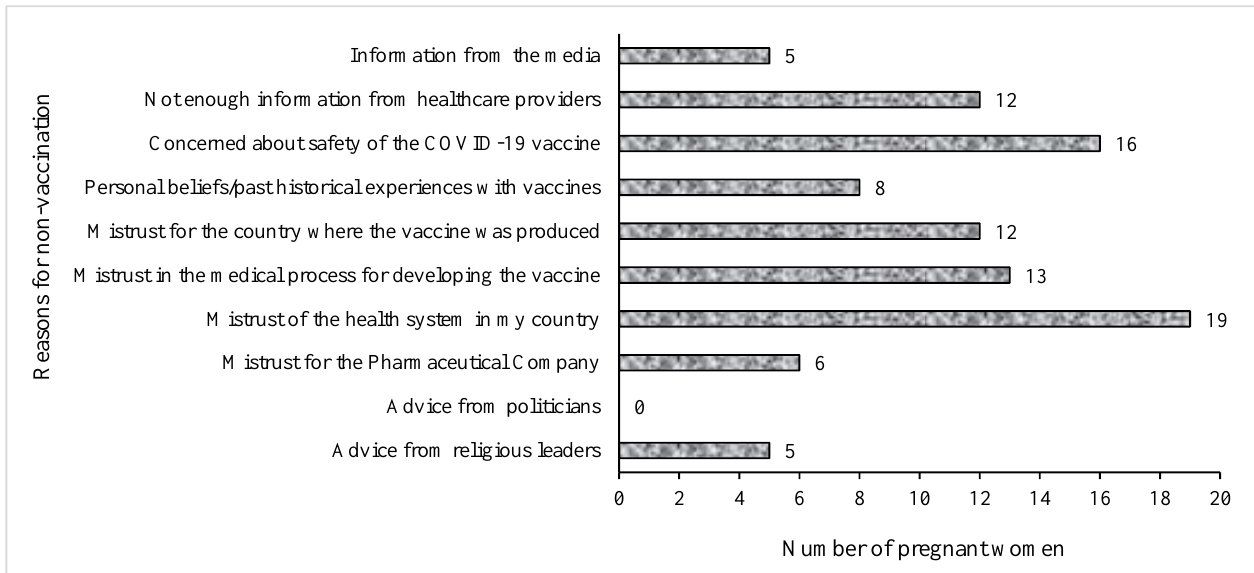
Figure 3. Previous vaccinations based on pregnancy status. Participants selected multiple responses. MMR — measles – mumps – rubella combination vaccine; DPT — diphtheria, pertussis and tetanus; BCG — Bacille Calmette – Guérin.